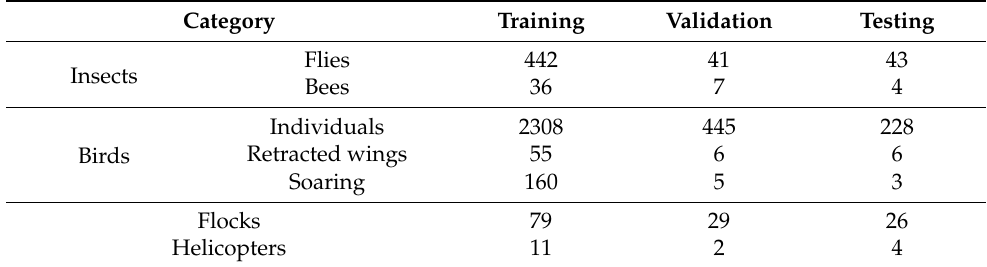
Figure 8. Categorizing the collected images (Individual birds: spread/retracted wings; insects: bees and flies; helicopters; flocks). Table 2. The categories and their counts in the training, validation, and testing subgroups.